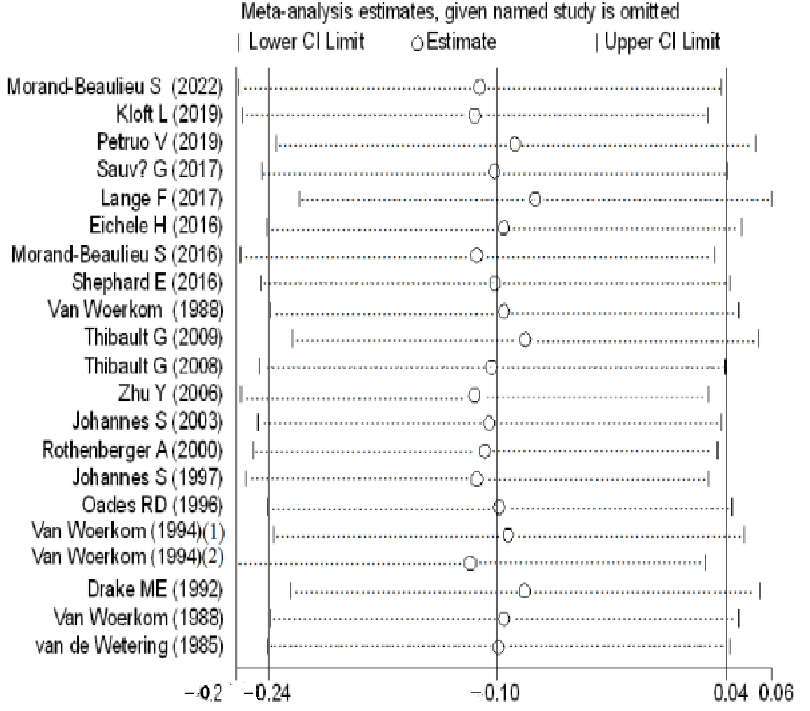
Figure 6. Sensitivity analysis of P3b latency of TD patients and HCs. CI: confidence